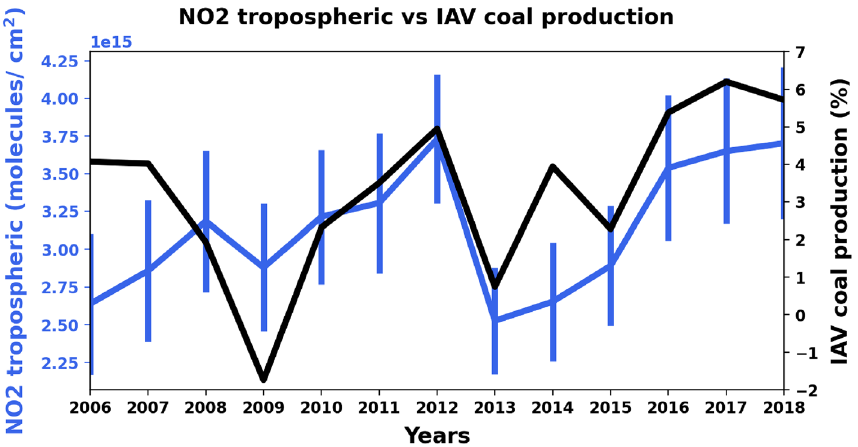
Figure 4. Annual average tropospheric NO 2 (blue line with error bars representing one standard deviation) and coal production IAV (black line) in Kuzbass for the years 2006–2018 (see Table S5 in supplementary material for numerical estimates) of NO 2 tropospheric